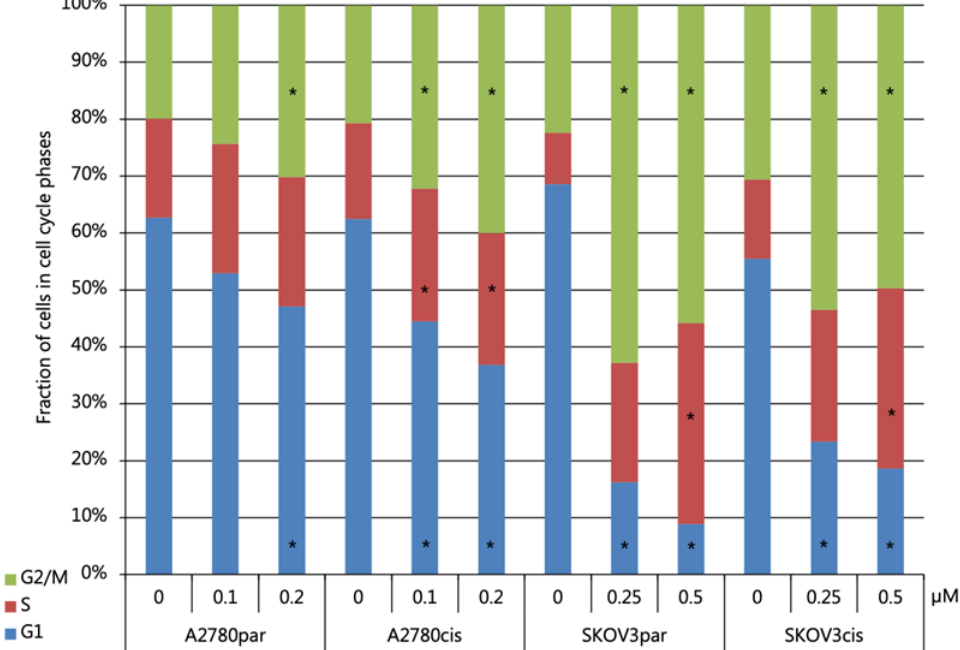
Figure 2. Cell cycle distribution of untreated cells or cells treated with 7 with indicated concentra- tions in µM. Significant changes of cell fractions in cell cycle phases compared to untreated cells were marked (Student´s t -test , mean values of ≥ 3 replicates , * p <